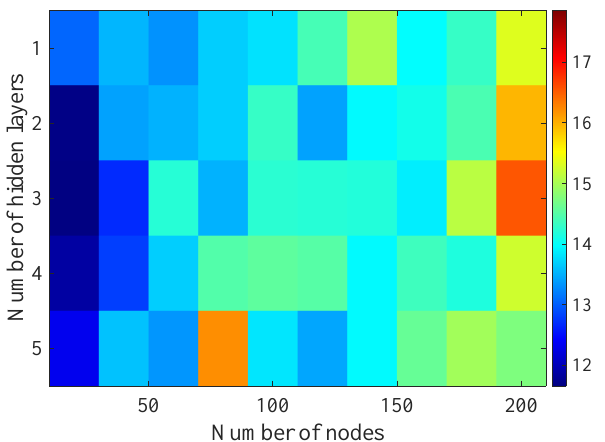
Figure 11. Matrix of the BLER RMSE metric predictions for the radio parameters history window W = 15.